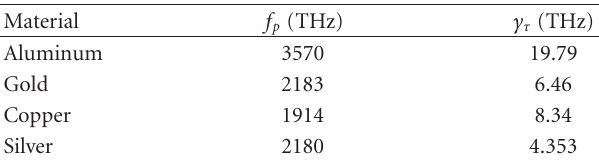
Figure 1: The growth of SP-related research in number of articles from 1980 to 2010, data acquired from Google Scholar (http://scholar.google.com/, accessed on Feb 10, 2012). Table 1: Plasmonic frequencies and damping factors for Al, Au, Cu, and Al in NIR spectrum